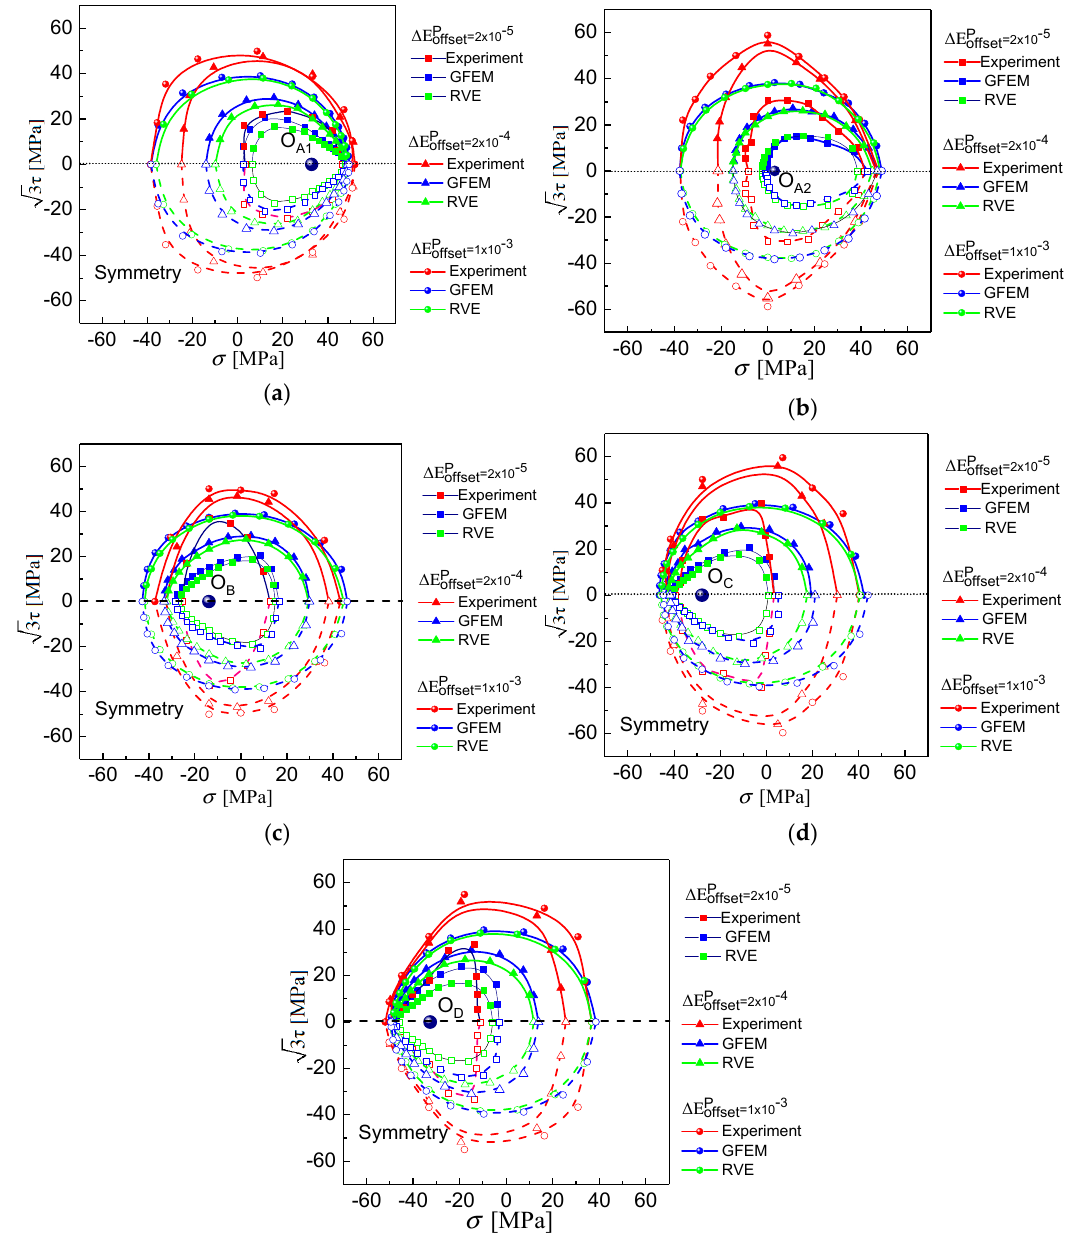
Figure 12. Subsequent yield surface tested and simulated by test and crystal plasticity with the GFEM and RVE after 30 tension–compression pre-cycles. ( a ) unloaded from A to O A1 ; ( b ) unloaded from A to O A2 ; ( c ) unloaded from B to O B ; ( d ) unloaded from C to O C ; ( e ) unloaded from D to O D .